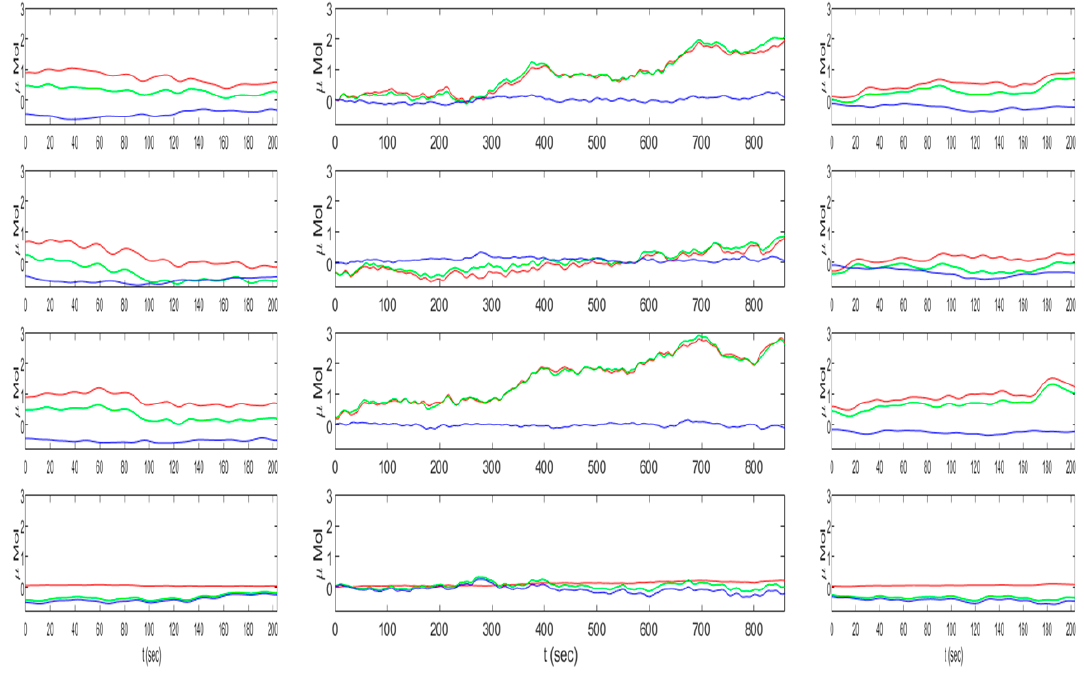
Figure 5. Average HbO 2 (red), Hb (blue), and HbT (green) data epochs for SCWT-pre meditation and SCWT-post tasks in columns left, middle, and right for all subjects and channels 1, 2, 3, and 4 in rows from top to bottom, respectively.